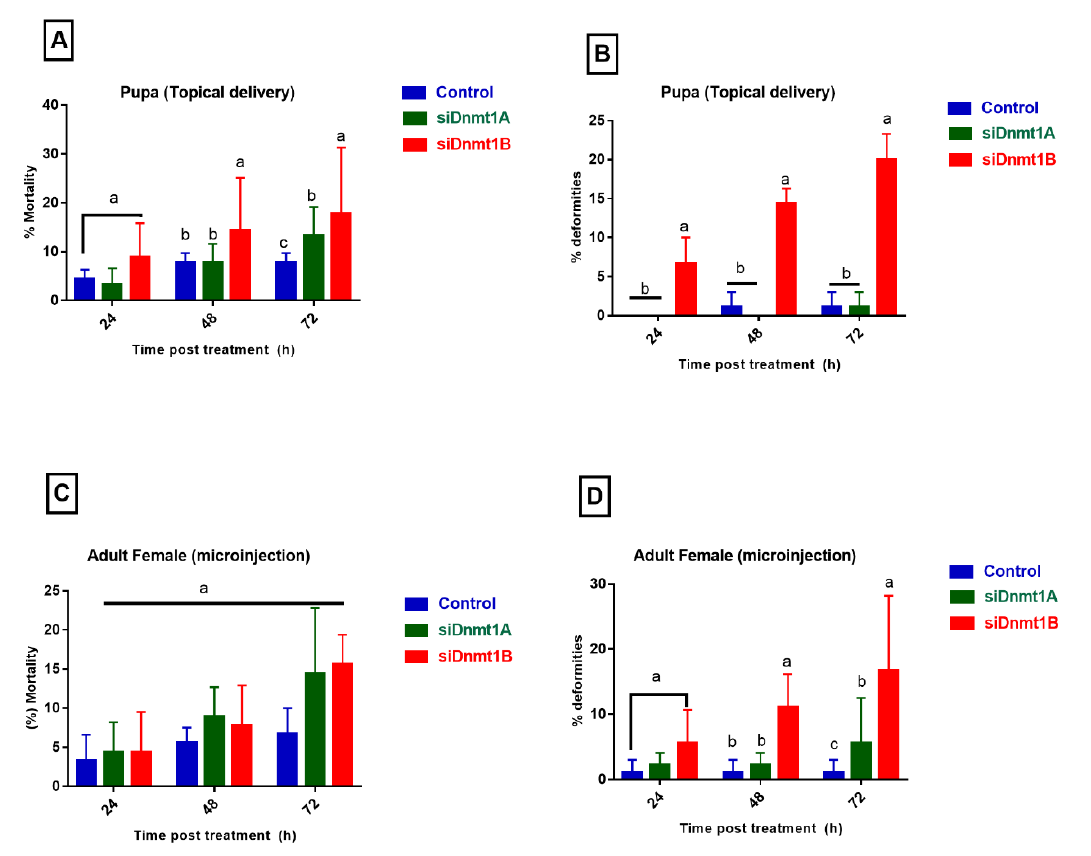
Figure 4. Phenotypic deformities and mortality rate in cotton mealybugs after silencing the DNMT genes by injection and topical delivery of siRNA. Each replicate consisted of 30 individuals that were analyzed at three-time points (24 h, 48 h, and 72 h) post-treatment. ( B ) The number of deformities corresponds to wing deformities. ( D ) The number of deformities corresponds to both black body color and dead o ff spring. Mortality and the number of deformities were normalized as mean ± SE with three biological replicates and analyzed by one-way ANOVA in conjunction with TUKEY test. Bars with di ff erent lowercase letters (abc) indicate significant di ff erences between treatments ( p < 0.05).